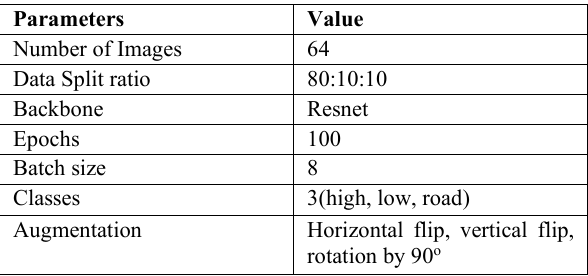
Table 1: Key experimental parameters used in the U-Net model Parameters